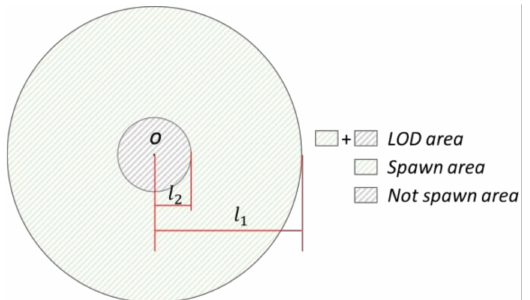
Figure 3. LOD area. O : the location of the autonomous vehicle; l 1 : the radius defining the LOD area; l 2 : the radius of the region visible to the autonomous vehicle, highlighted in gray.